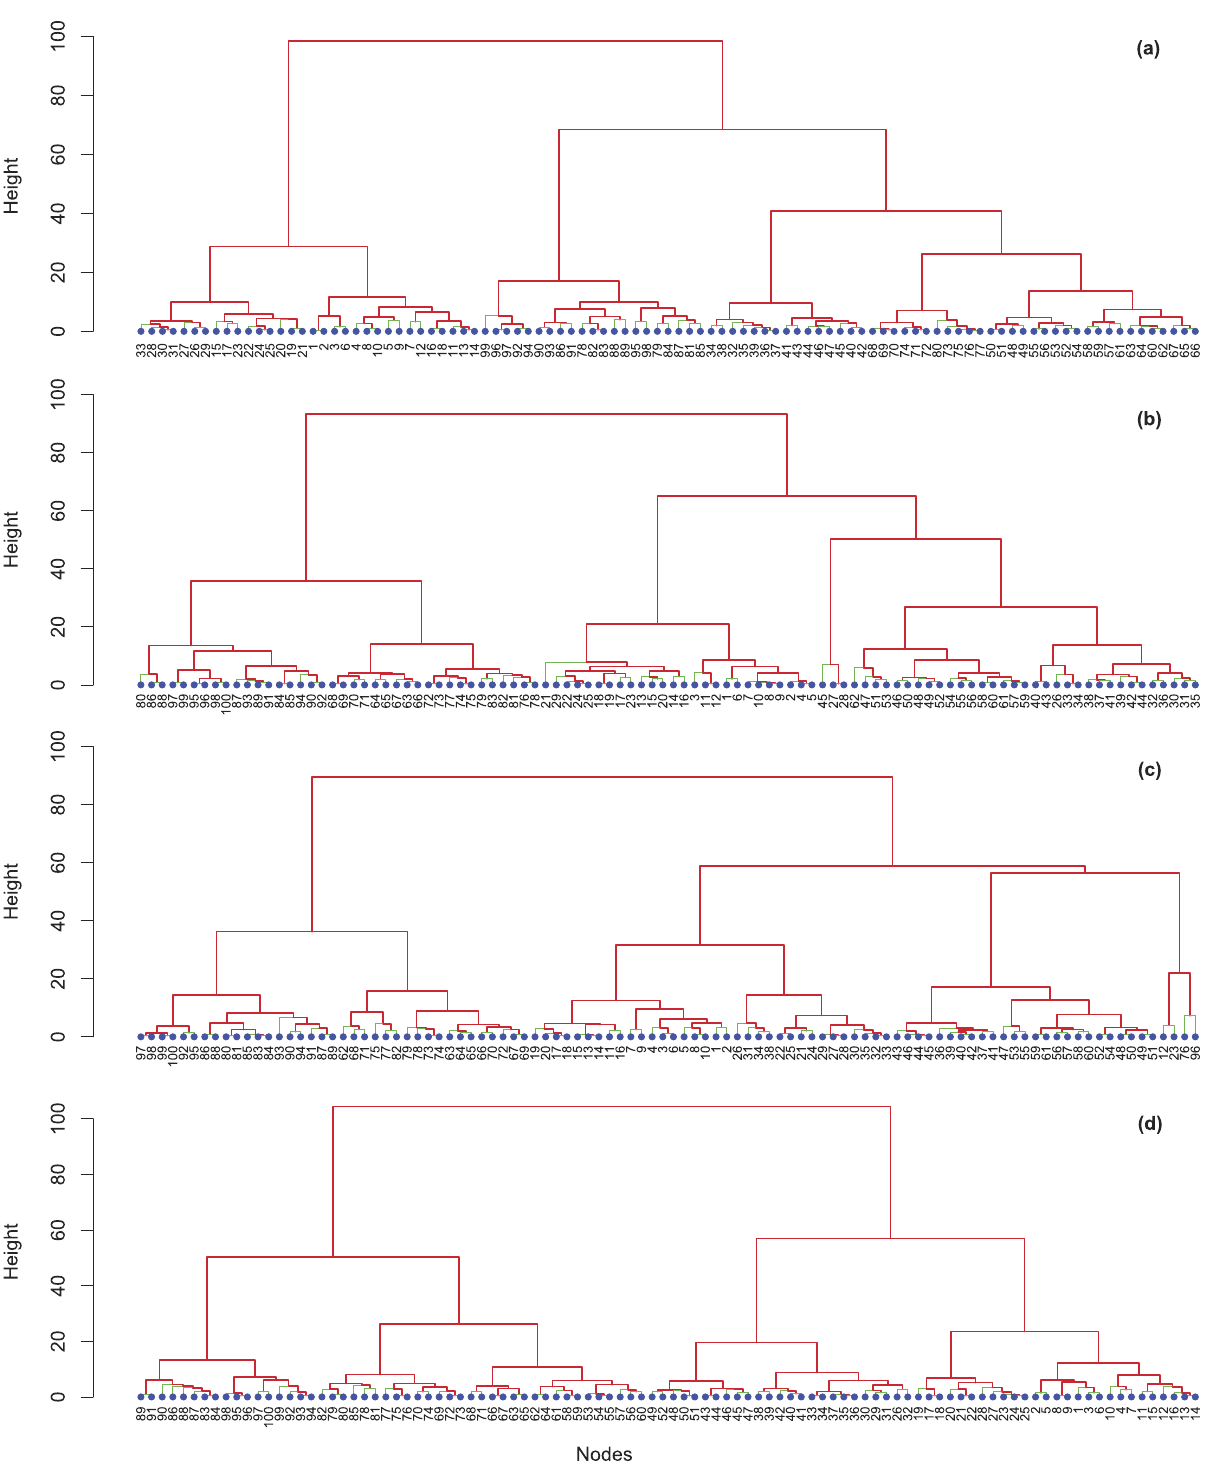
Fig 3. Hierarchical clustering of nodes in the multiplex network based on gut similarity. We show the hierarchical clustering and re-clustering of nodes based on their gut similarity in the multiplex network in the various temporal windows: before feedback (a), after the first feedback round (b), after the second feedback round (c), after the third feedback round (d). Nodes change the clusters to which they belong according to their modifications in dietary uptake rates.